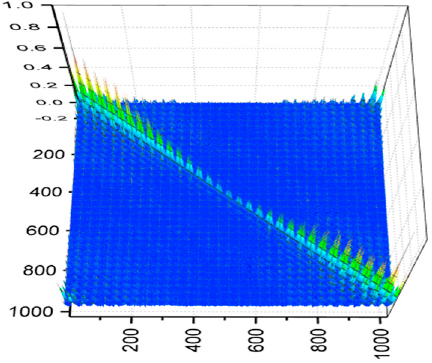
Figure 3. The element distribution diagram of the Gram matrix of the atmospheric measurement matrix.